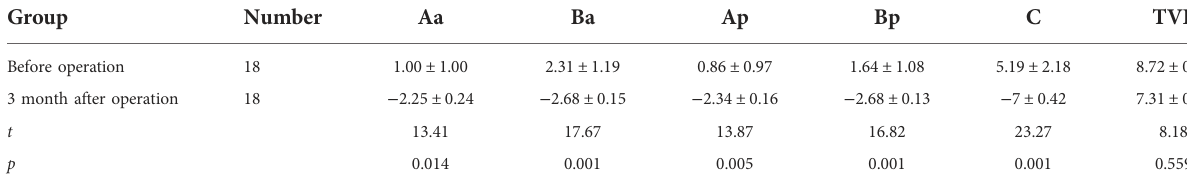
TABLE 3 POP-Q scores before and 3 months after operation.